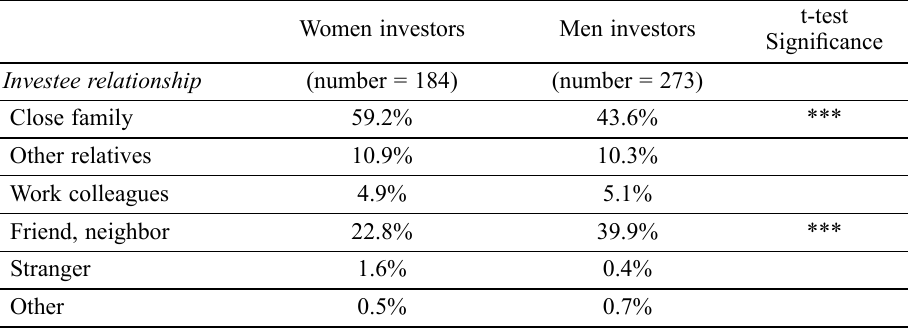
Table 7. Gender differences in the relationships of informal Chilean investors to